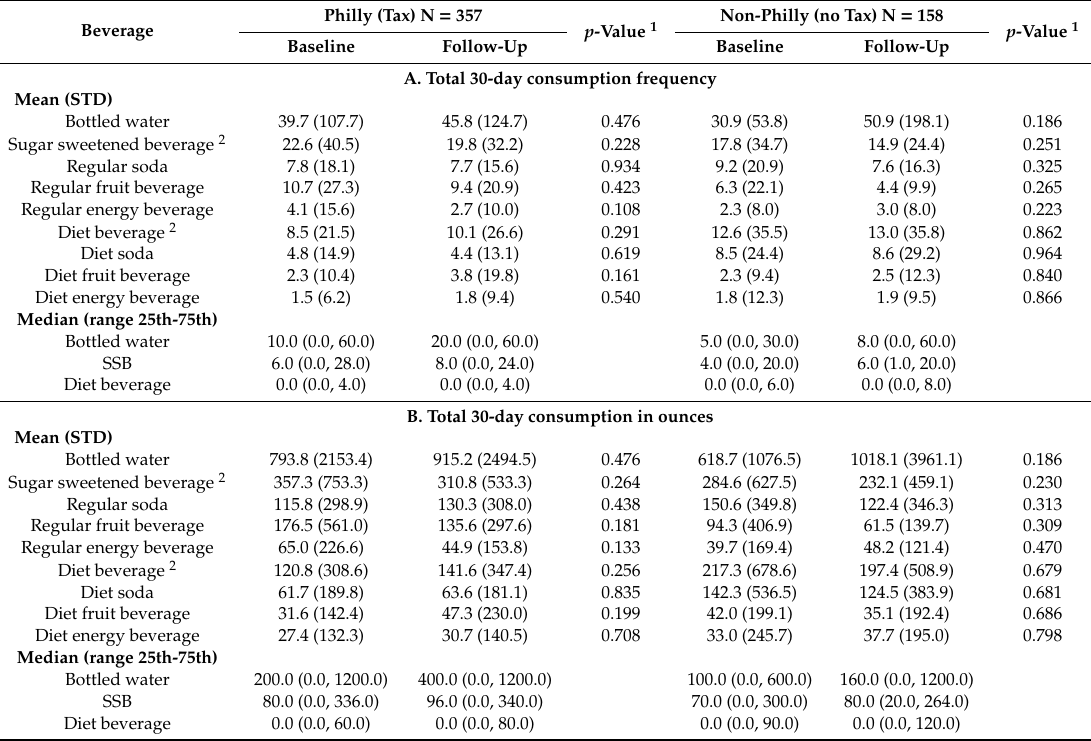
Table 2. Frequency and mean of bottled water, sugar-sweetened and diet beverage consumption during baseline and follow-up, N = 515.